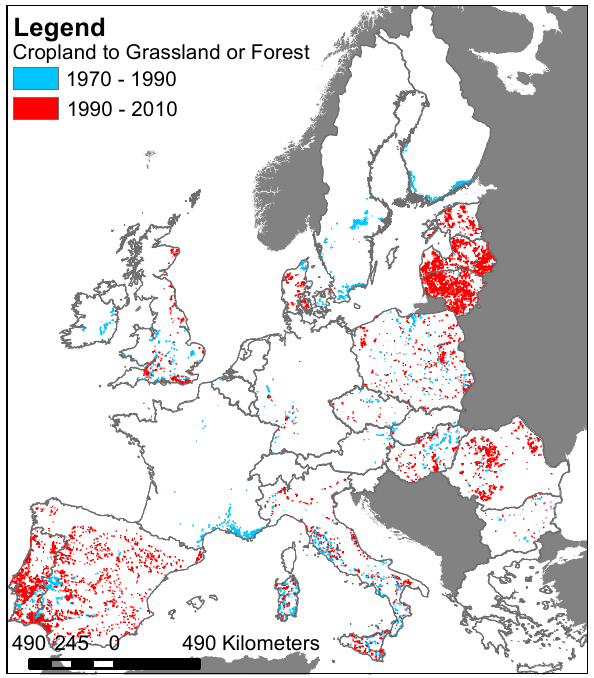
Fig. 11. Prime areas with loss of cropland. Cropland to grassland or forest is displayed separately for two 20-yr groups, before and after the introduction of the Common Agricultural Policy in